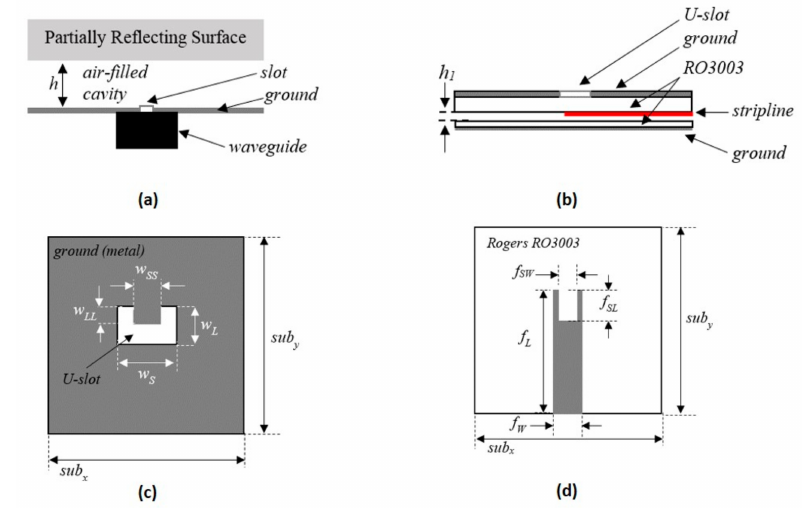
Figure1. Structuralschematicoftheproposedplanarfeed, ( a )configurationofwidebandresonant-cavity antennas (RCAs) fed using conventional waveguides, ( b ) vertical cross section of the antenna, showing the stripline and the air-gap, ( c ) top view of the antenna, showing the U-slot cut in the ground plane, ( d ) horizontal cross section of the antenna, showing the